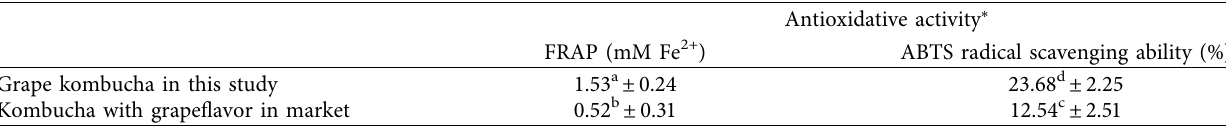
Table 2: Comparison of antioxidative activity between grape kombucha in this study and kombucha with grape flavor in market.